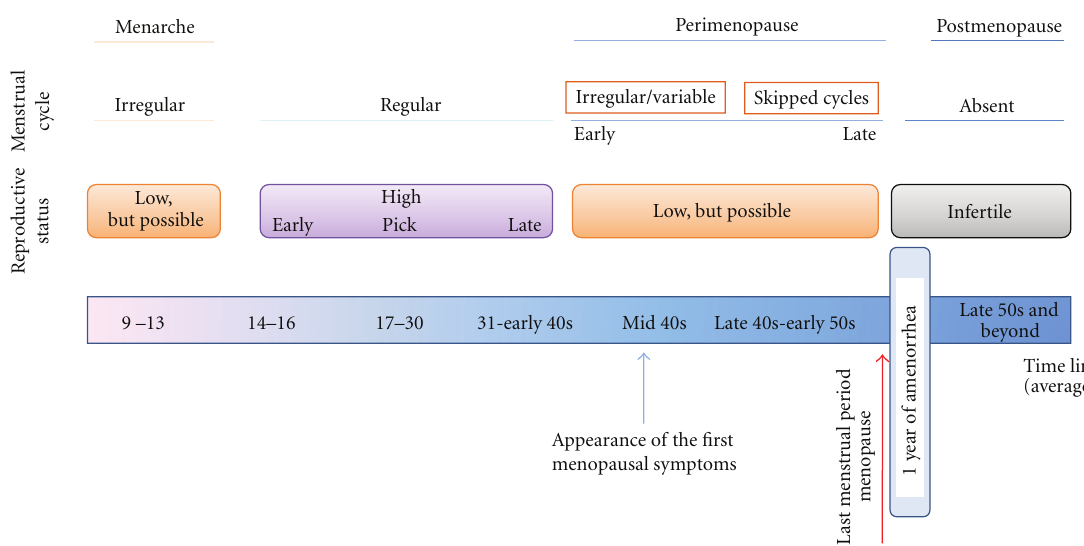
Figure 1: Women reproductive stages during aging: from menarche to postmenopausal. Time line represents only an average for the normal age. More details can be found in the